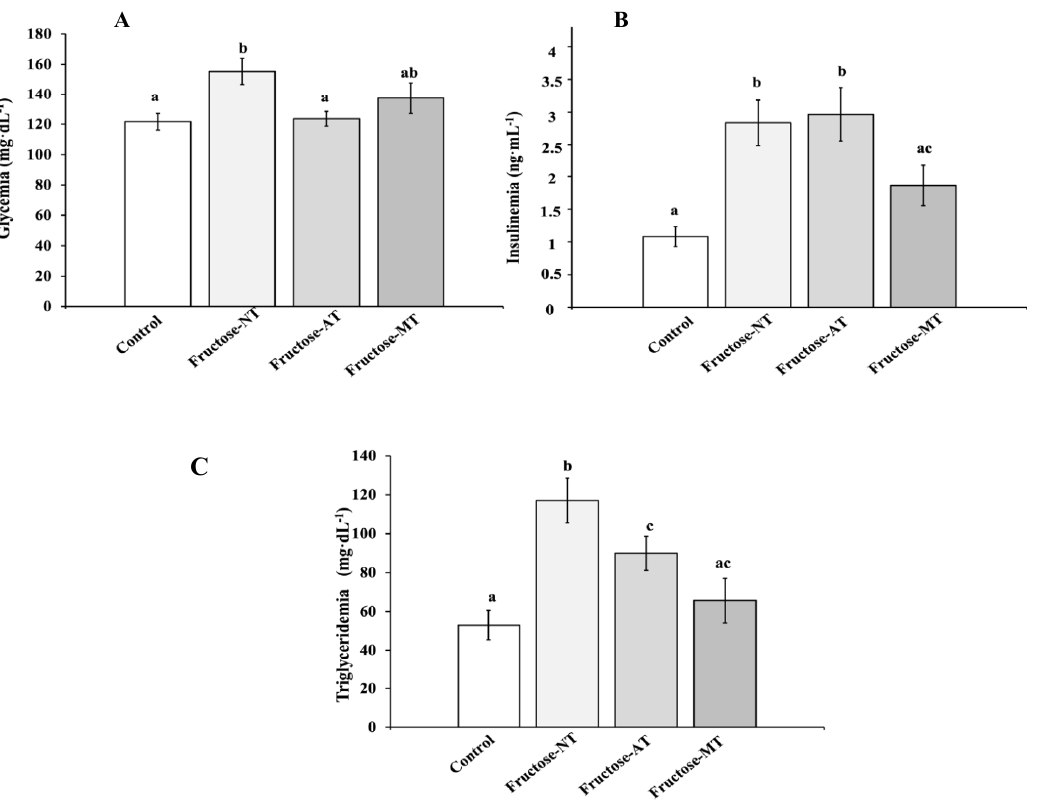
Figure 2. Biochemical parameters evaluated at the end of the experiment (week 8). (A) Blood glucose (B) Insulinemia (C) Triglycerides levels. Different letters show significant differences at ( p < 0,05).